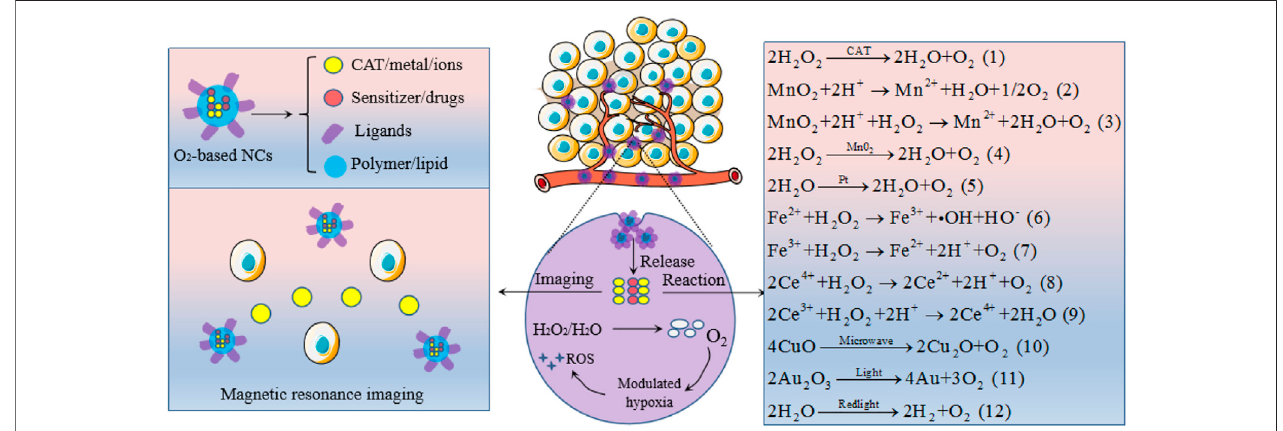
FIGURE 4 | Oxygen-generating NCs to modulate tumor hypoxia and to endow magnetic resonance imaging. The speci fi c mechanisms of oxygen generation are represented by chemical